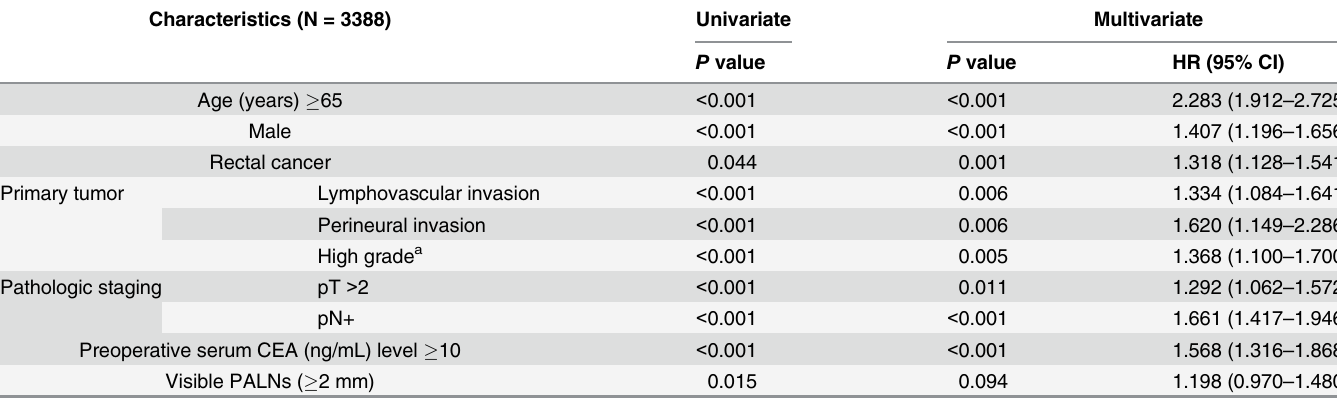
Table 2. Univariate and multivariate Cox regression analysis of prognostic factors for overall survival in patients without distal metastases. Characteristics (N =